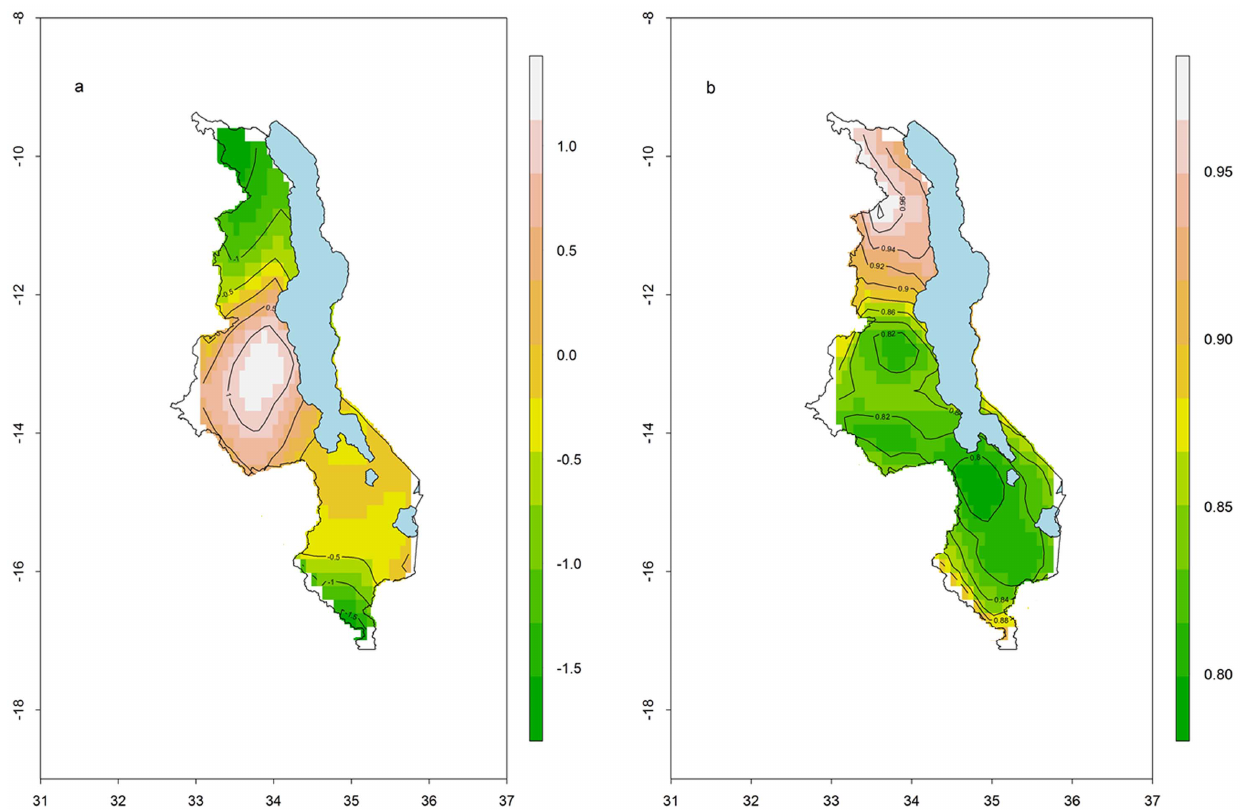
Figure 4. Risk map of malaria in children less than 5 years. (a) Predictive risk map of malaria in children less than 5 years (b) Standard errors associated with the risk map. Green (brown) colours represent lower (higher) standard errors.